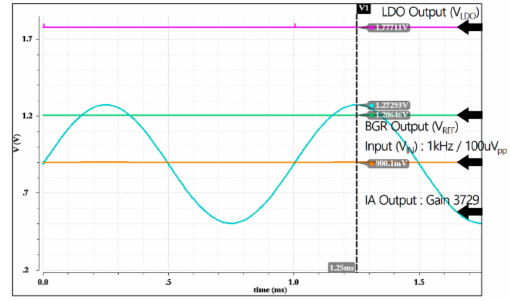
Figure 9. Post-layout simulation results of the radiation-hardened